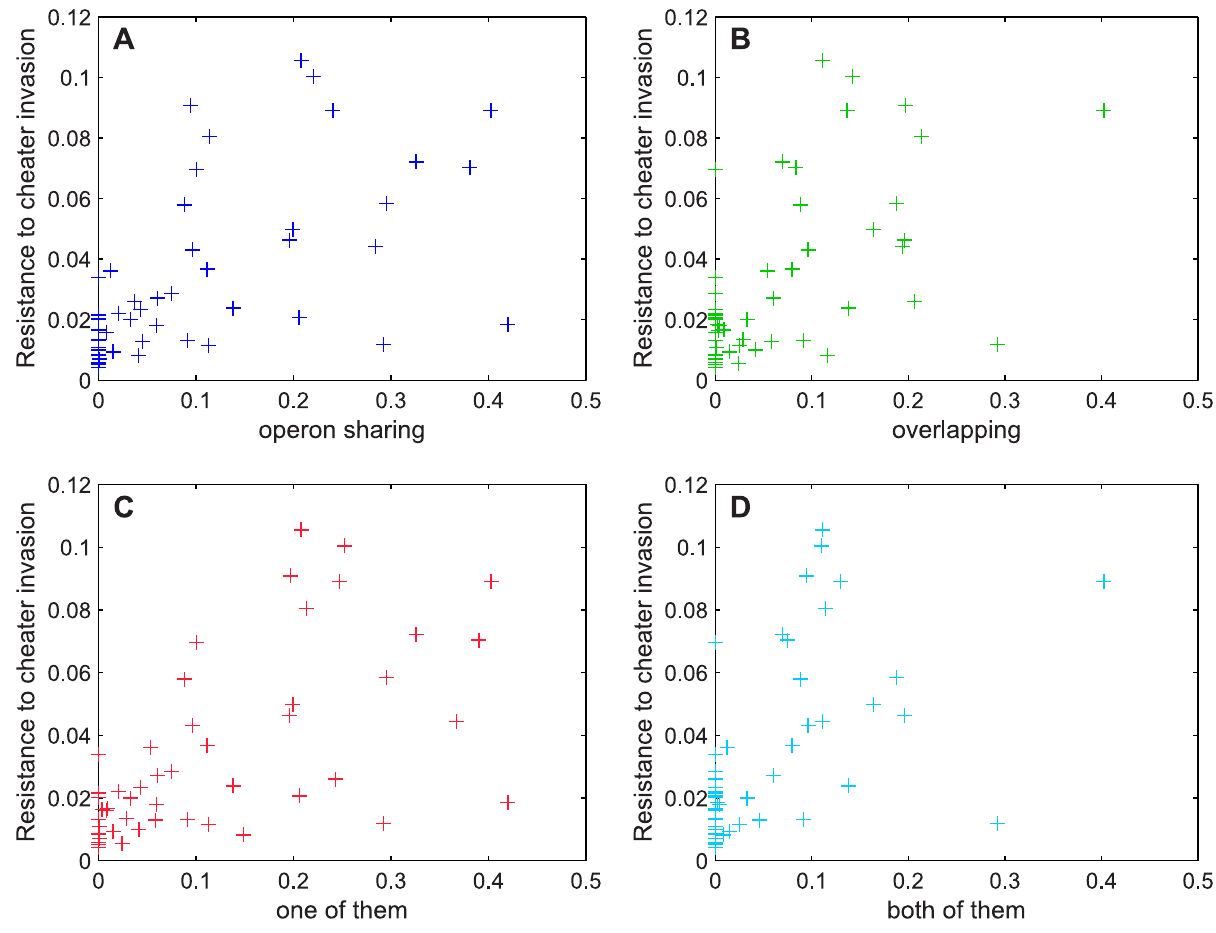
Figure 3. Correlation between the genetic architecture of cooperation genes and the resistance to cheater invasion. Resistance is measured by the amount of secretion surviving cheater invasion. The four types of associations between secretion and metabolic genes shown here are: sharing an operon (A, dark blue), overlapping (B, green), having at least one of the previous two properties (C, red), and having both of them (D, light blue).